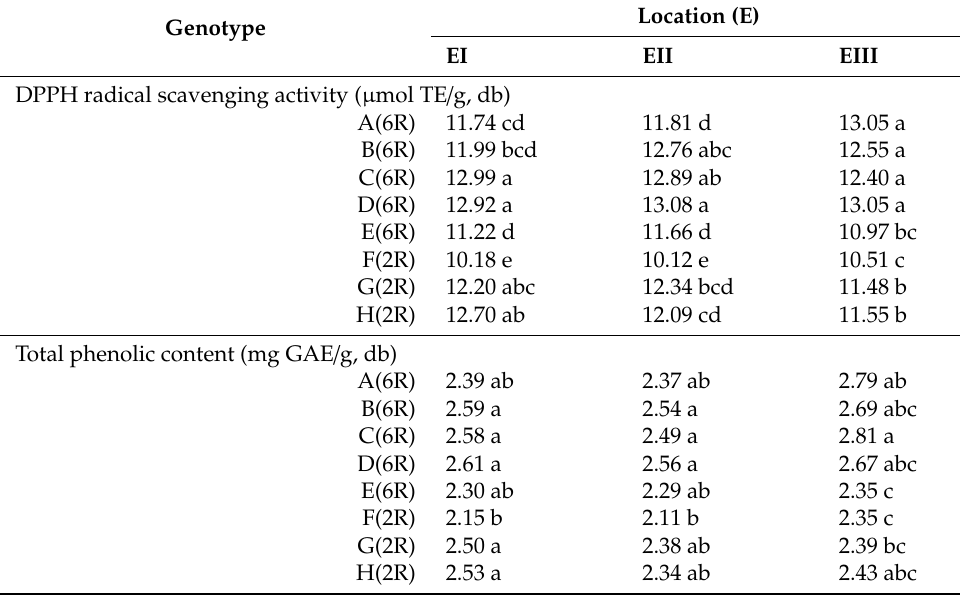
Table 2. Ranking of Genotype in Di ff erent Locations for DPPH Radical Scavenging Activity and Total Phenolic Content Significantly influenced by G × E